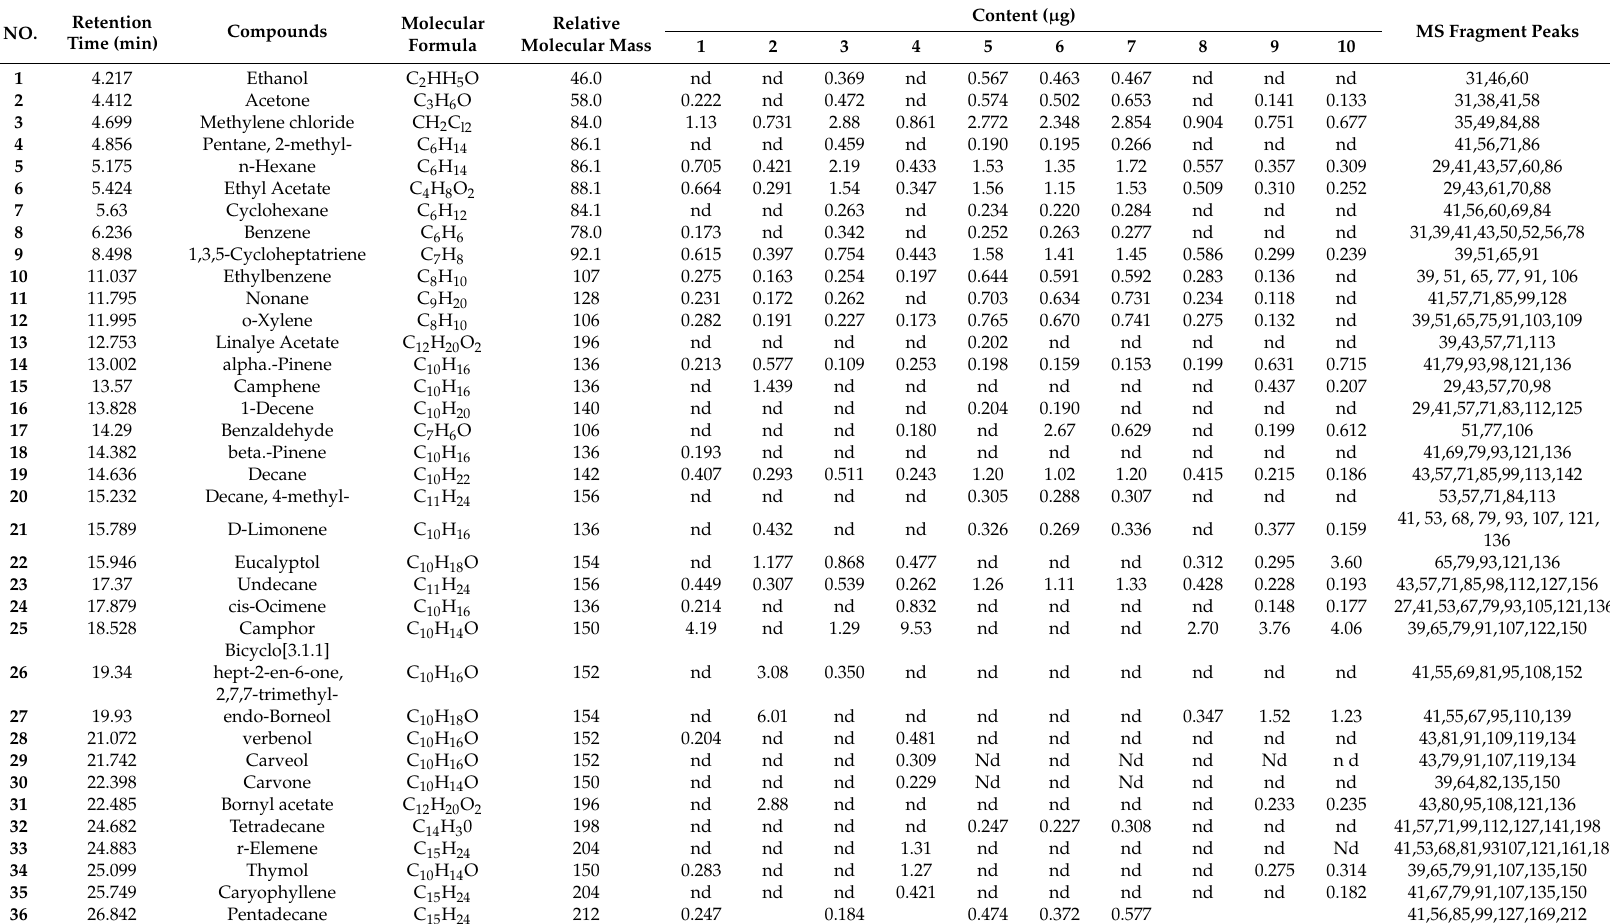
Table 2. Volatile compounds released from the flowers of 10 varieties of Chrysanthemum morifolium